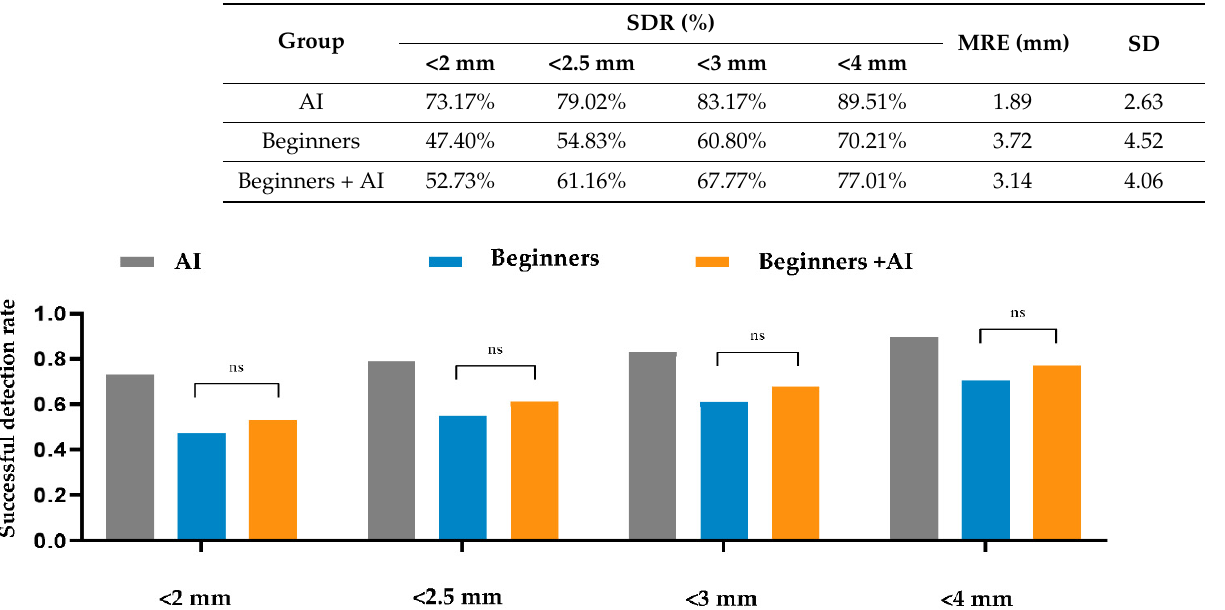
Table 5. Successful detection rate and mean radial error for each landmark within a 2 mm threshold.